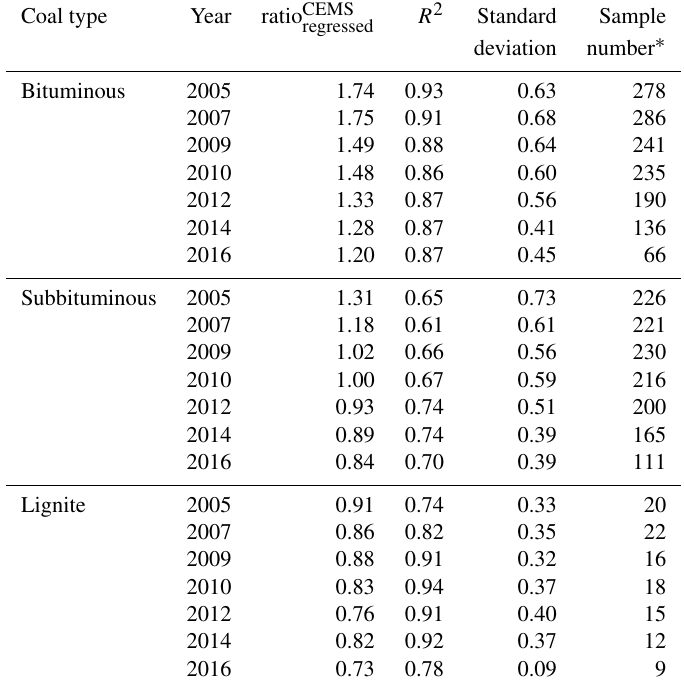
Table 1. The slope (ratio CEMS ), coefficient of determination, standard deviation, and sample number of the linear regression of E CEMS regressed and E CEMS by year for all US power plants without post-combustion NO x control devices from 2005 to 2016. CO 2